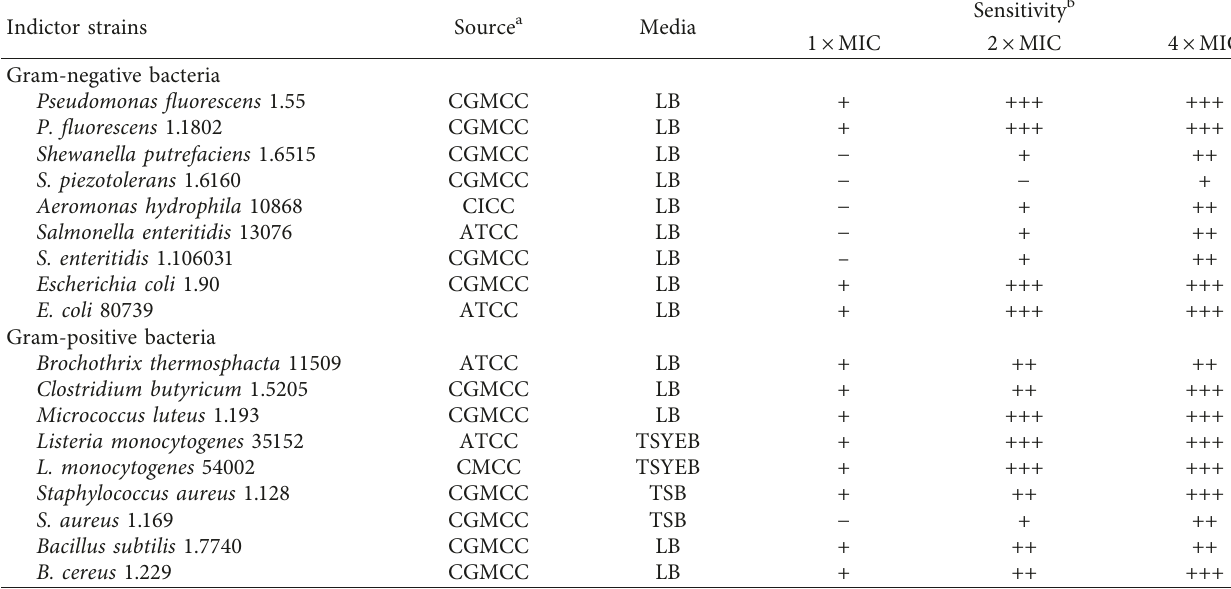
Table 2: Antimicrobial spectrum of the films incorporated with bifidocin